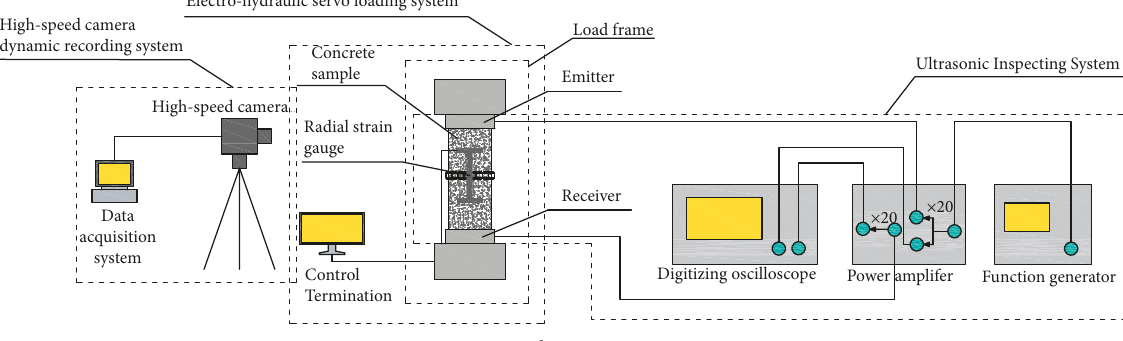
Figure 3: Integrated test system construction.